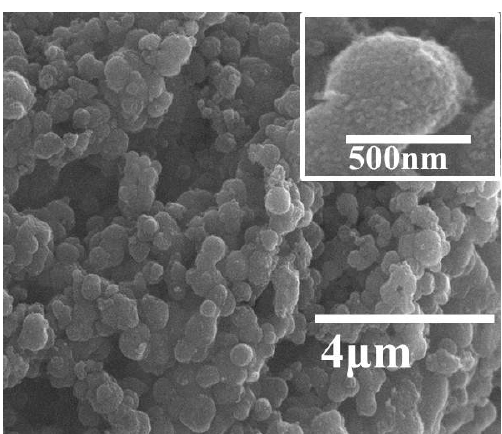
Figure 12. Surface images of the used RCP-AG(15).